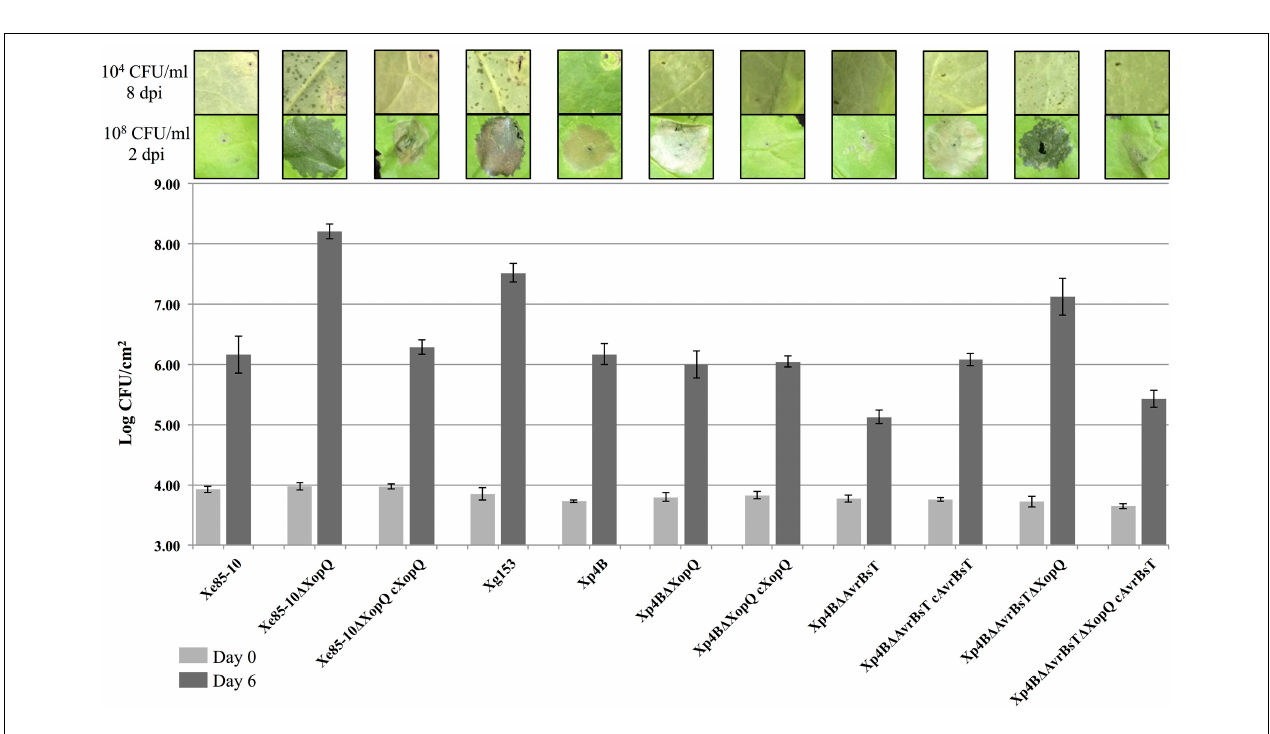
FIGURE 5 | Host expansion of Xanthomonas spp. on Nicotiana benthamiana . In planta growth of X. perforans and AvrBsT and XopQ deletion mutants measured at Days 0 and 6 with a starting inoculum of 10 5 CFU/mL after infiltration of leaves of Nicotiana benthamiana . Infiltrations on N. benthamiana were